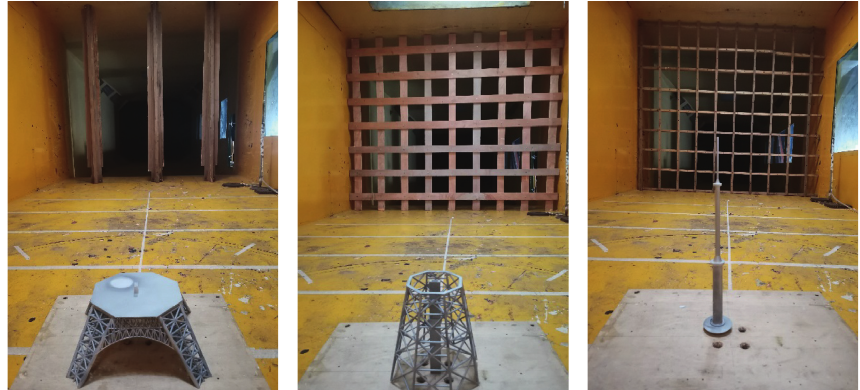
Figure 4: Images of the sectional model of the tower in the wind